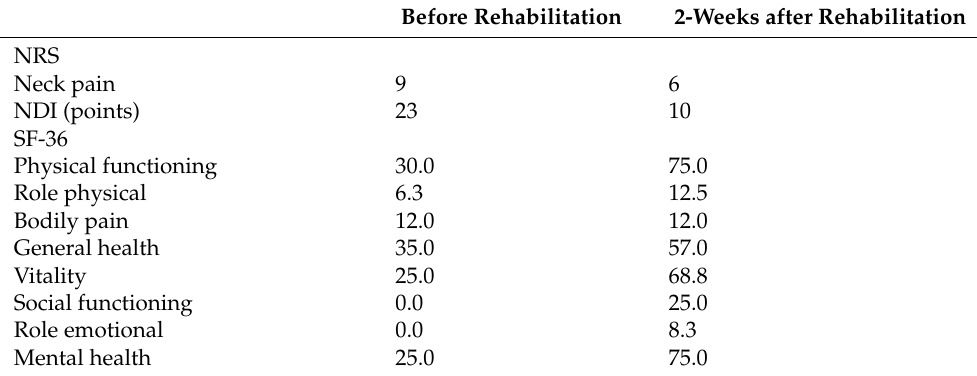
Table 2. Patient-Reported Outcomes.